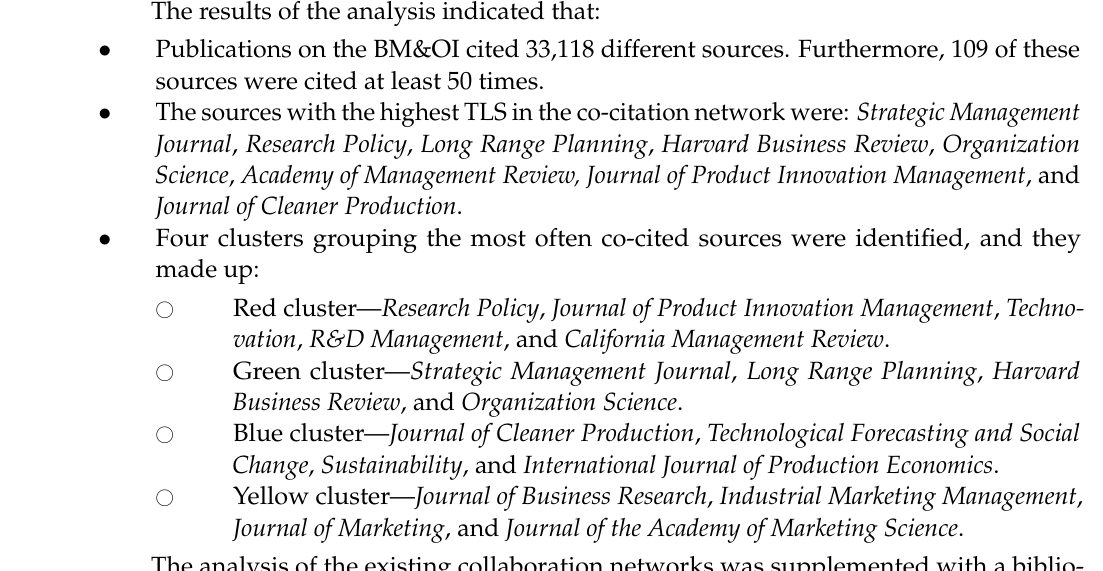
Figure 11. The most significant documents with the highest TLS are presented in Table A7.